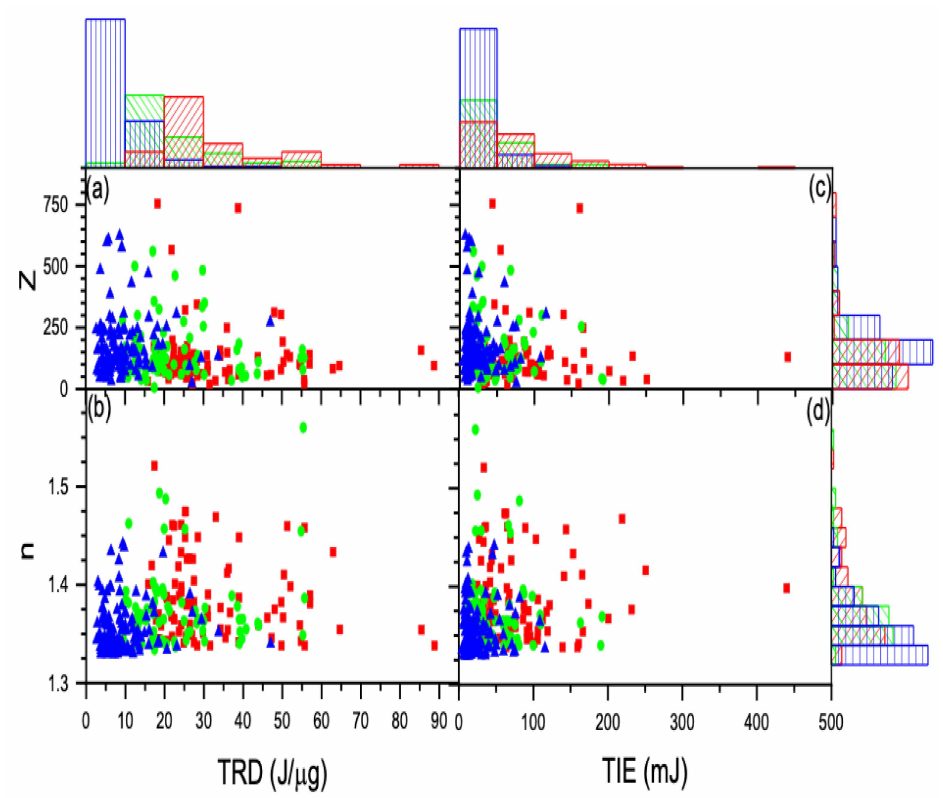
Figure 10. The calculated charge and refractive index vs. TRD ( a ) and ( b ) vs. TIE ( c ) and ( d ) along with the corresponding distributions displayed using histograms: control (red), 2 h-treated (green), and 24 h-treated (blue). The charge is measured by the z